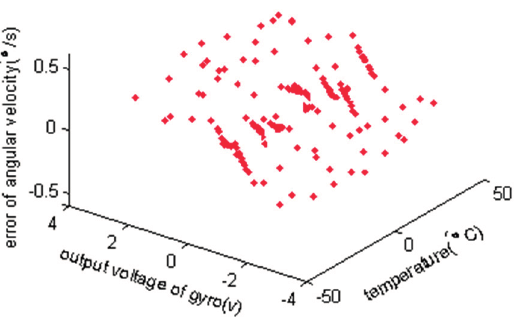
Figure 12. The angular velocity error of the verification data after